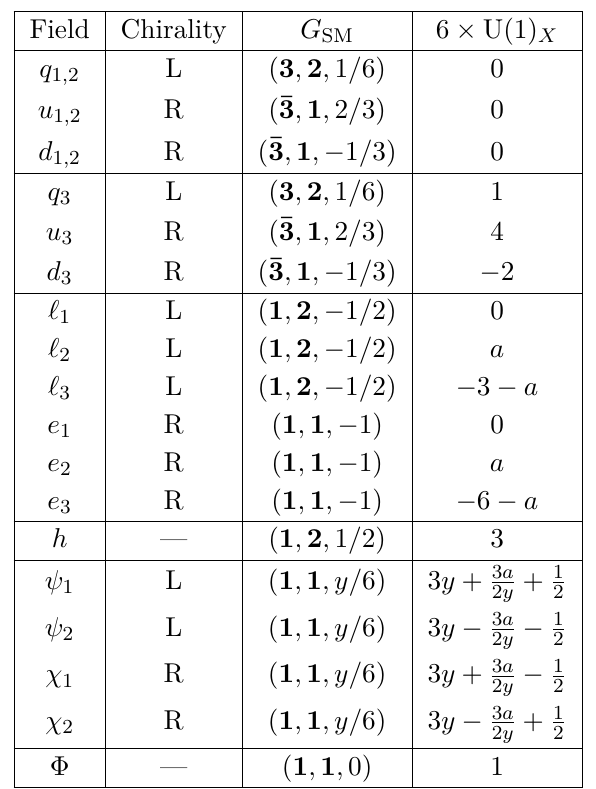
Table 1 . The anomaly-free set of U(1) X charges present at the TeV scale for our model. At energies below the TeV scale the extra Weyl fermions are integrated out, leaving an anomalous U(1) symmetry that acts as X = Y + a ( L ) on the SM fermions. In the final column we record the 3 µ − L τ 6 values of the U(1) charges multiplied by six. It is assumed that a is an odd multiple of y , which X makes all the charges (multiplied by 6) integral in this